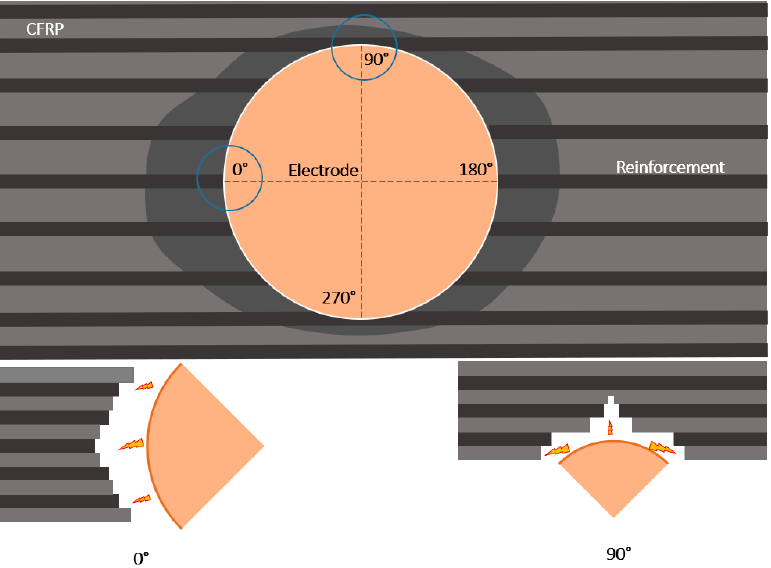
Figure 4. Graphical representation of electric discharge propagation as a function of the fibre orientation.